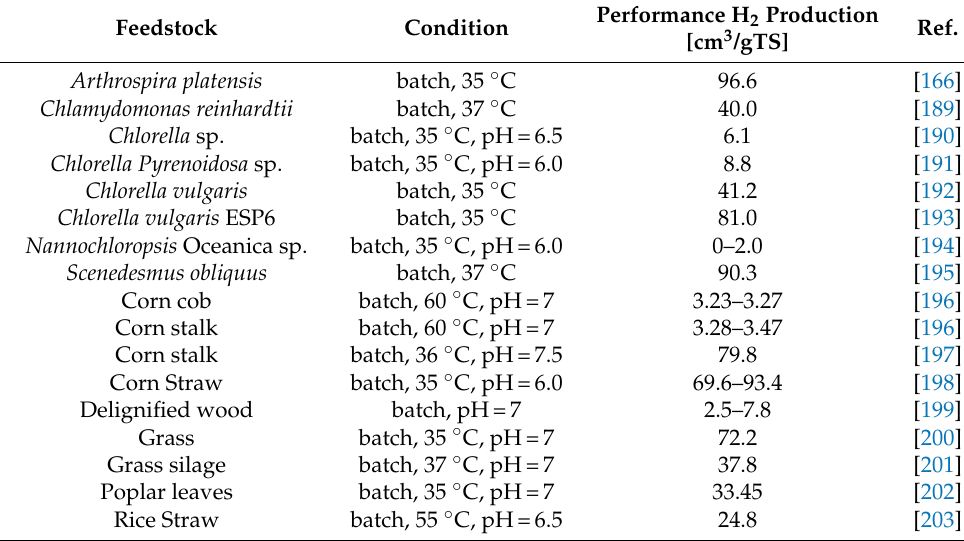
Table 4. Comparison of literature data on algal and cellulose-based biomass for biohydrogen